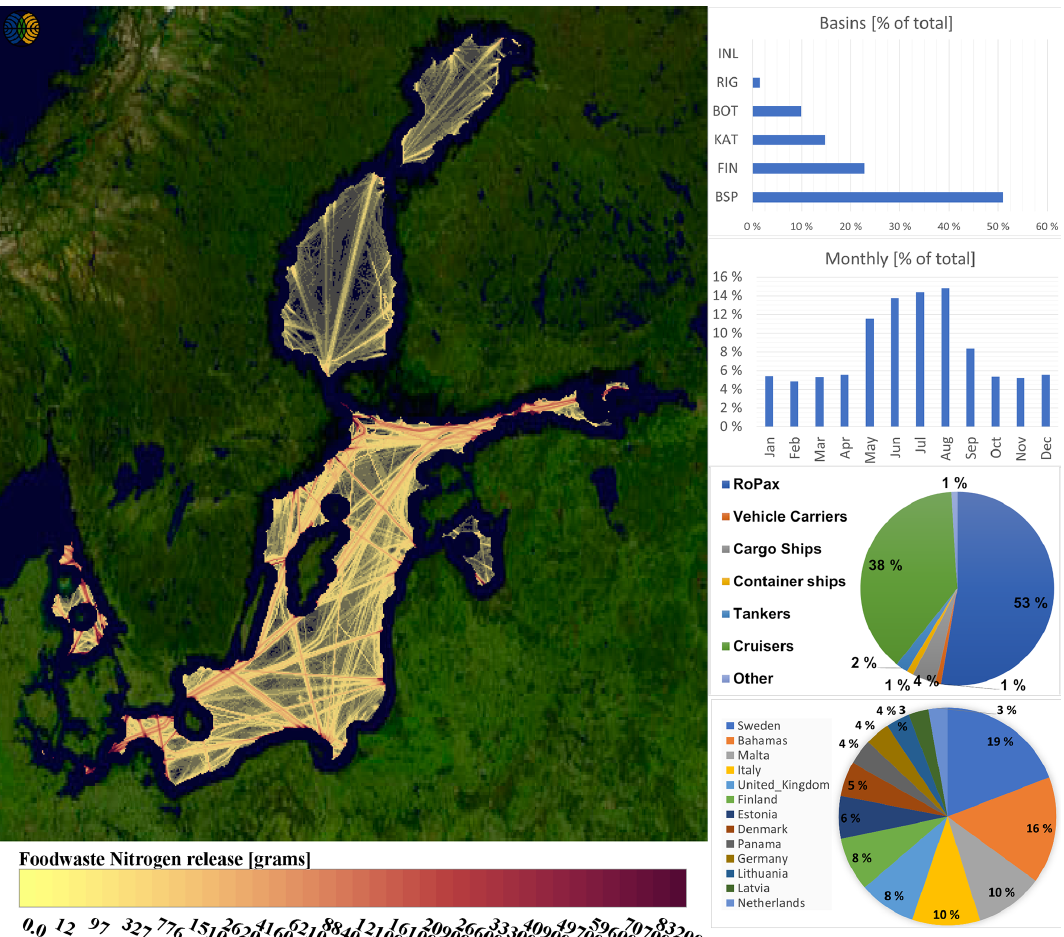
Figure 10. Food waste nitrogen discharges from ships during 2012 in units of grams per map grid cell area of 5km 2 . According to IMO rules, no discharge is allowed closer than 12nm distance from the coastline. The upper bar chart describes the contributions by sub-basin and the lower bar chart the monthly variation. The upper pie chart depicts the ship type and the lower pie chart the flag state contributions to food waste nitrogen releases. Map: background Landsat-8 image courtesy of the US Geological